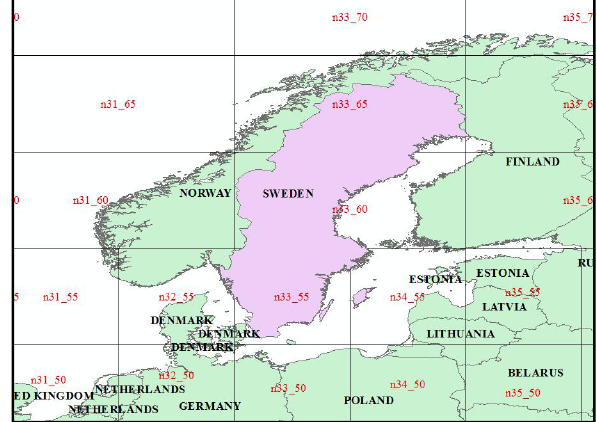
Figure 2 The geographic location of test site in the accuracy test, demonstrating Sweden consist of seven map sheets. Light purple area outline the area of Sweden.